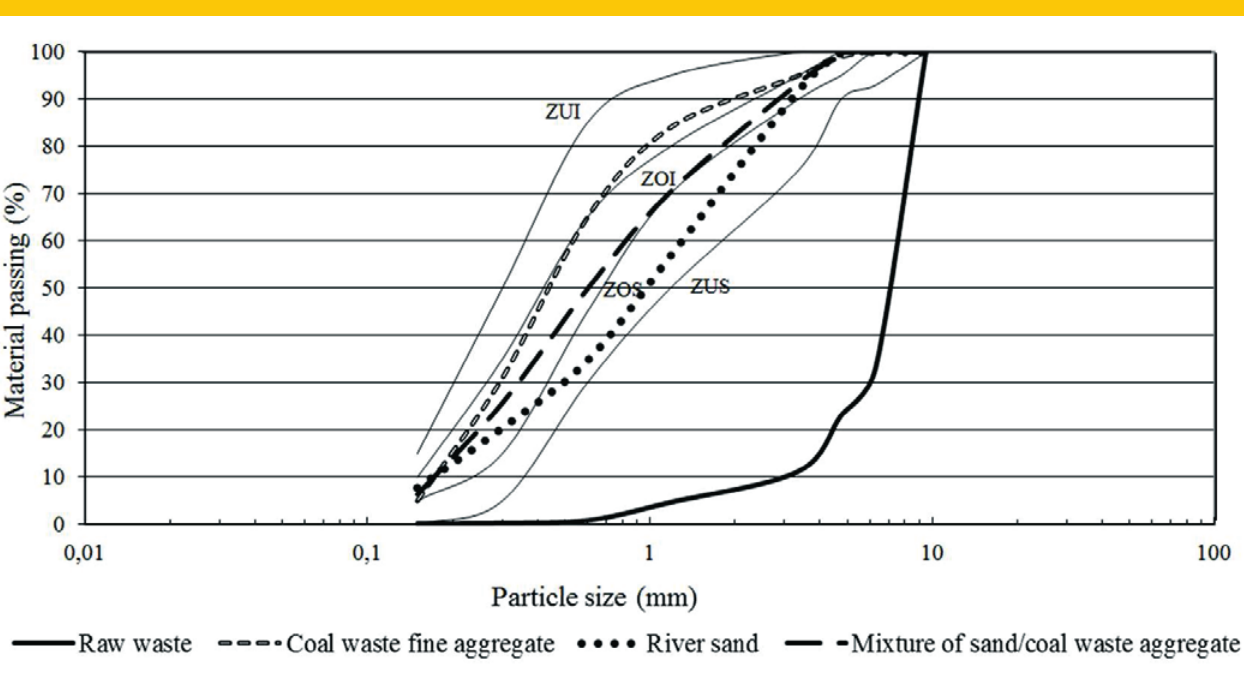
Figure 3 – Size particle distribution of raw coal waste, coal waste fine aggregate, river sand, and the mixture of sand/coal waste fine aggregate (50%) as well the lower and upper limits described by NBR 7211(ZUI and ZUS are, respectively, the lower and the upper limits of the applicable zone, and ZOI and ZOS are the lower and the upper limits of the optimal